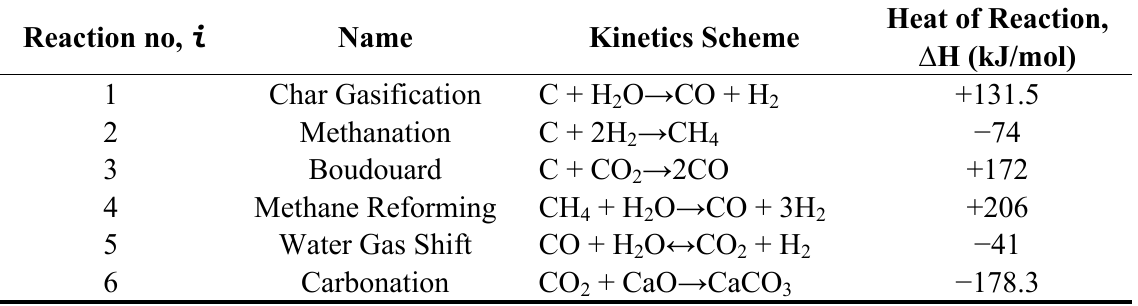
Table 1. Reactions occurring in the integrated steam gasification process